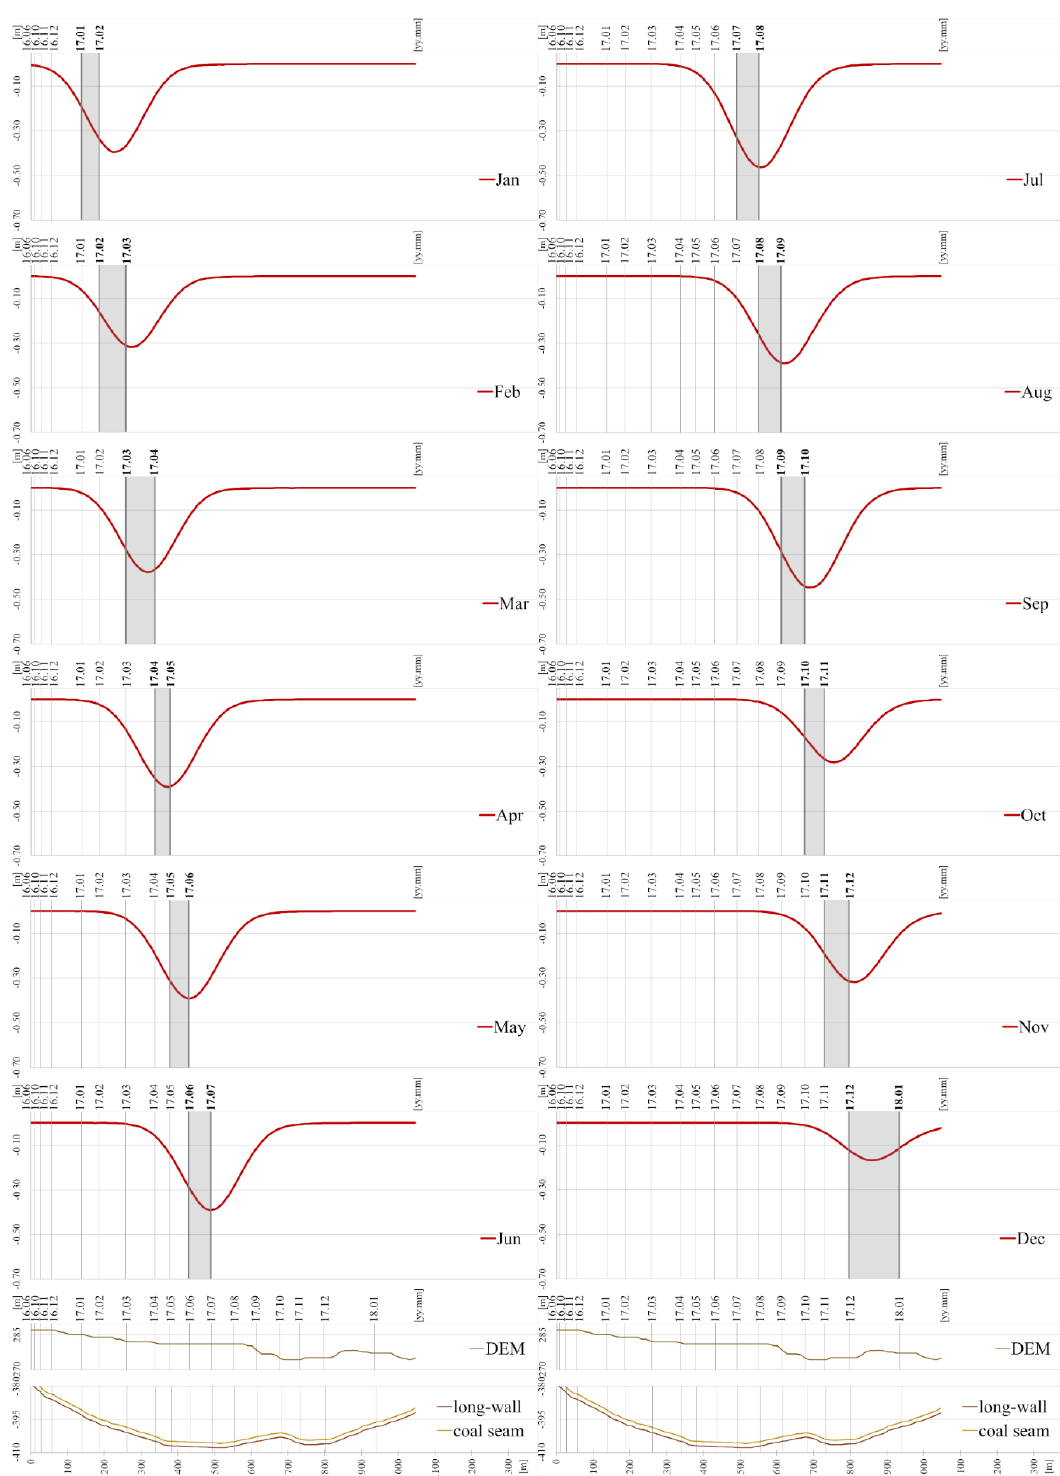
Figure 15. Profile A’A” (longwall No. 6) through the models. The red curves show the vertical subsidence by month in 2017. On the bottom of the figure, profiles of the DEM surface and depth and thickness of coal seam are presented.